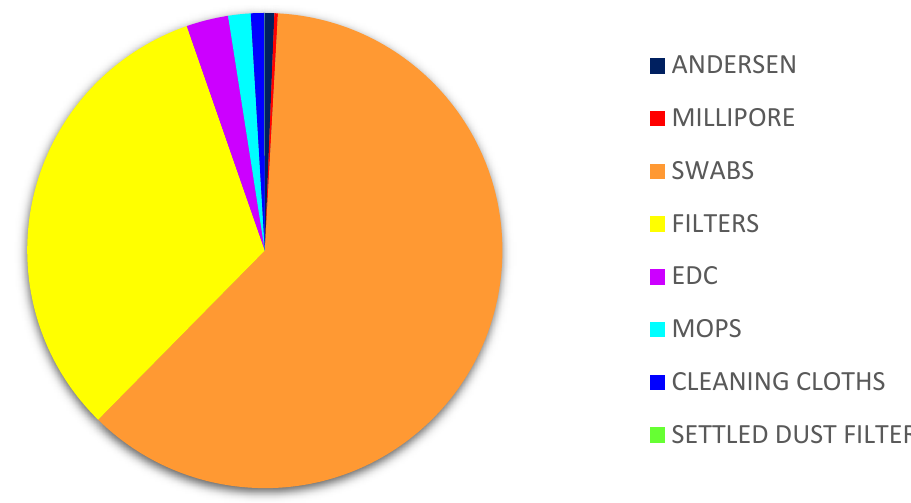
Figure 3. Aspergillus sp. distribution in samples on DG18. DG18: Dichloran–Glycerol Agar; EDC: Electrostatic dust collector.